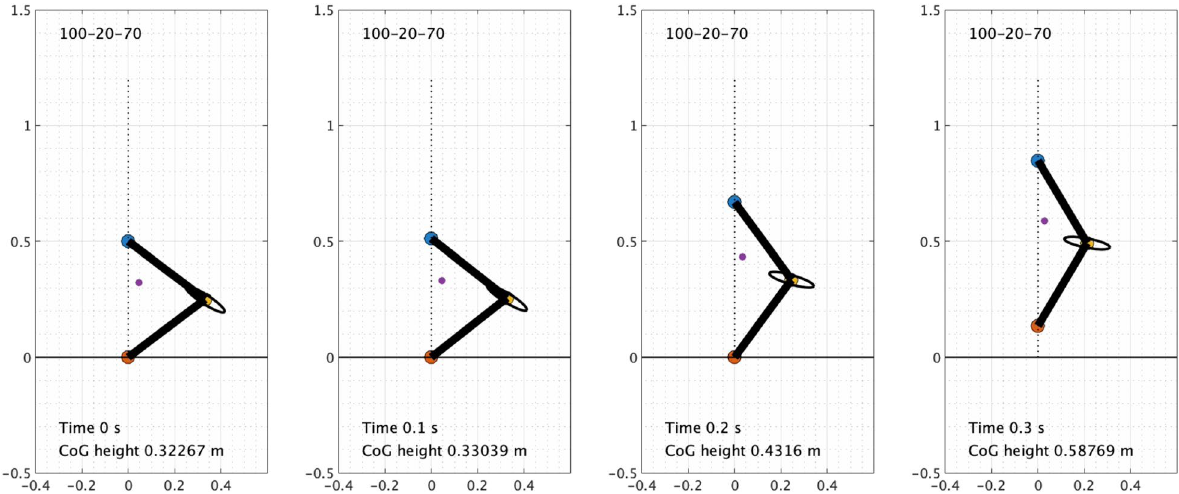
Fig. 9 The simulation of jumping when using ( a , b , α) = ( 100,20,70 ) patella